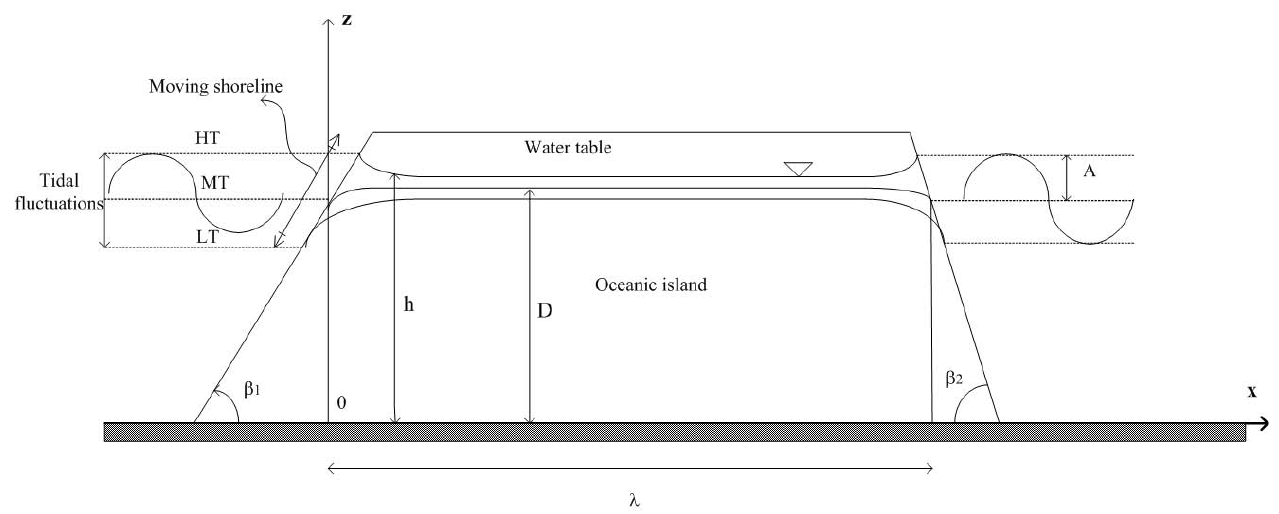
Fig. 1. The profile of tidal water table fluctuations in an oceanic island with sloping